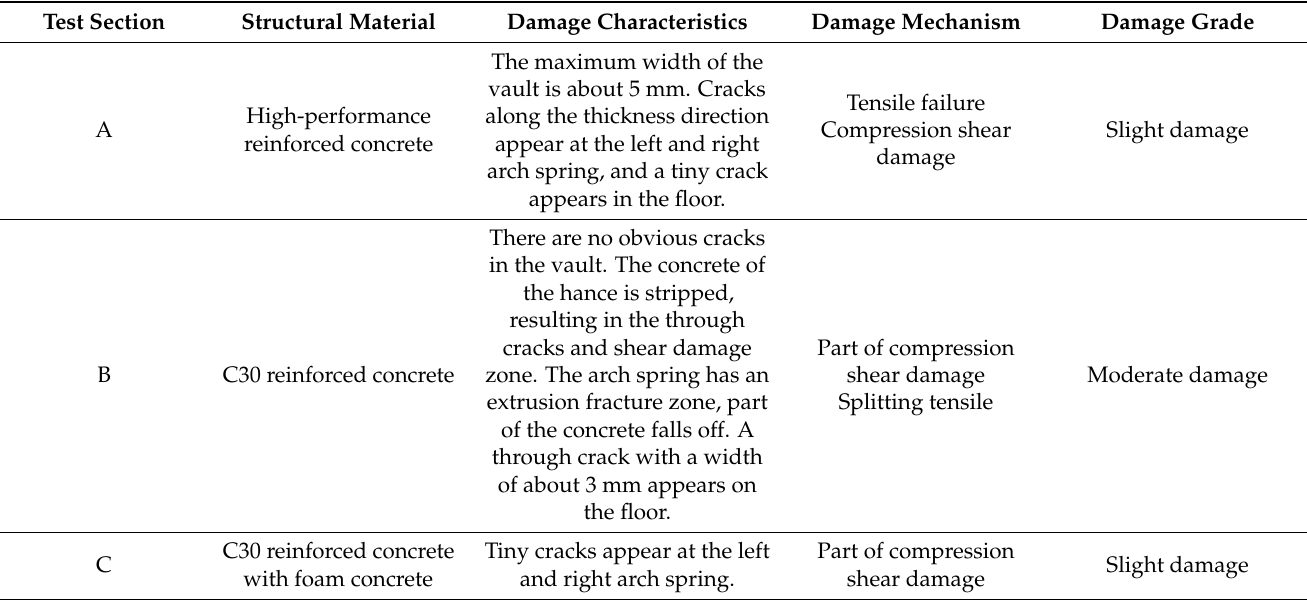
Table 6. The damage grades and damage characteristics of the test